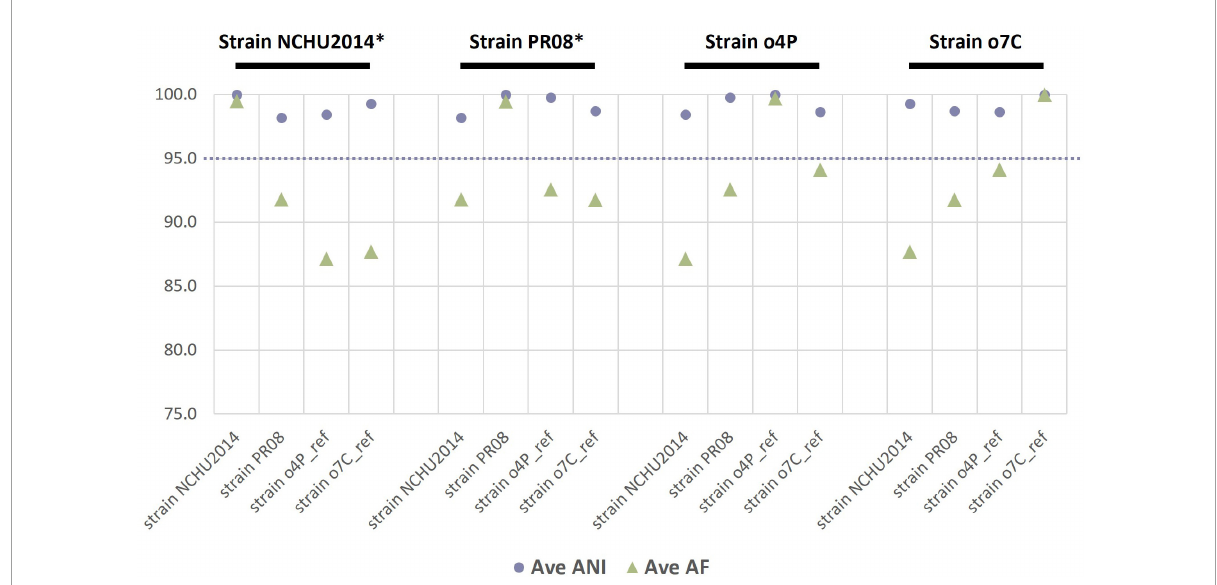
FIGURE1 Reciprocal mean average nucleotide identities (ANI, %) and proportion of aligned genomic segments (AF, %) for the two phytoplasma reference genomes assembled in this study and two publicly available phytoplasma reference genomes (strain NCHU2014 and strain PR08). The phytoplasma genome used as a reference in each case is indicated above the graph in black font, with an asterisk indicating a complete genome. The dashed line indicates the proposed 95% ANI species delimitation threshold